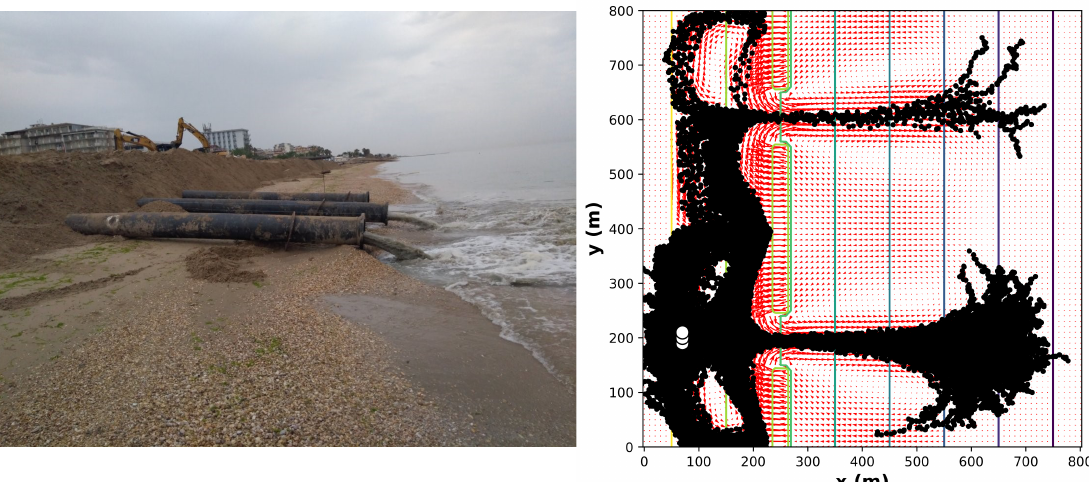
Figure 6. Typical results of a random walk model. The plot ( right ) refers to the dispersion of fine sediments due to nourishment ( left ) projects at a coastal defense cell when submerged breakwaters are present. Contour lines refer to the bathymetric configuration, arrows to the 2DH nearshore circulation forced by a sea state propagating along the x-direction, white circles indicate the re-suspension sources, black dots refer to the instantaneous location of passive